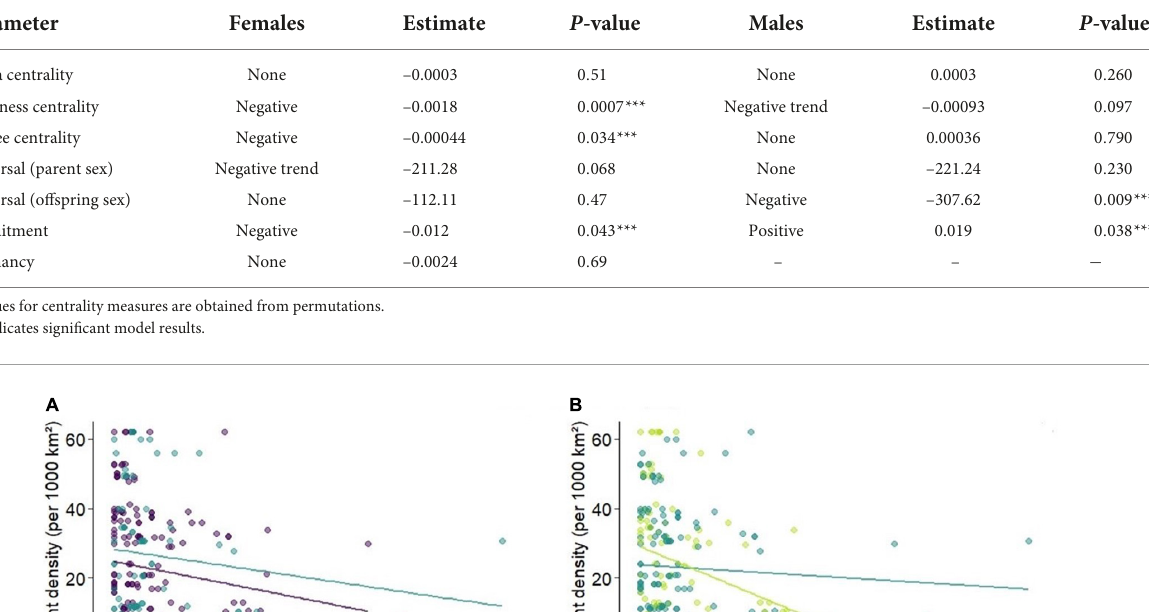
TABLE 3 Generalized linear model results for the effect of density on several demographic parameters.